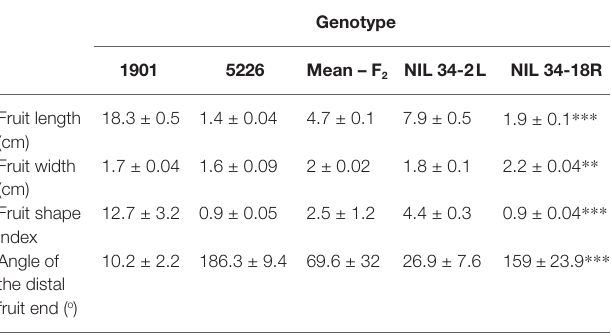
TABLE 1 | Fruit shape characteristics of parents, F 2 progeny, and fs10